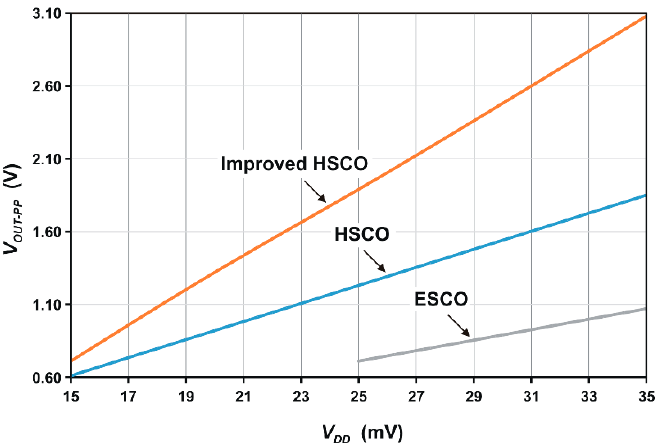
Figure 7. Peak ‐ to ‐ peak values of the output voltage, v OUT ‐ PP , as a function of the supply voltage, V DD , for ESCO, HSCO and improved HSCO ( G L 1 / g ds 1 = G L 1 / g dm 1 = 0.0025, Q L = 100).